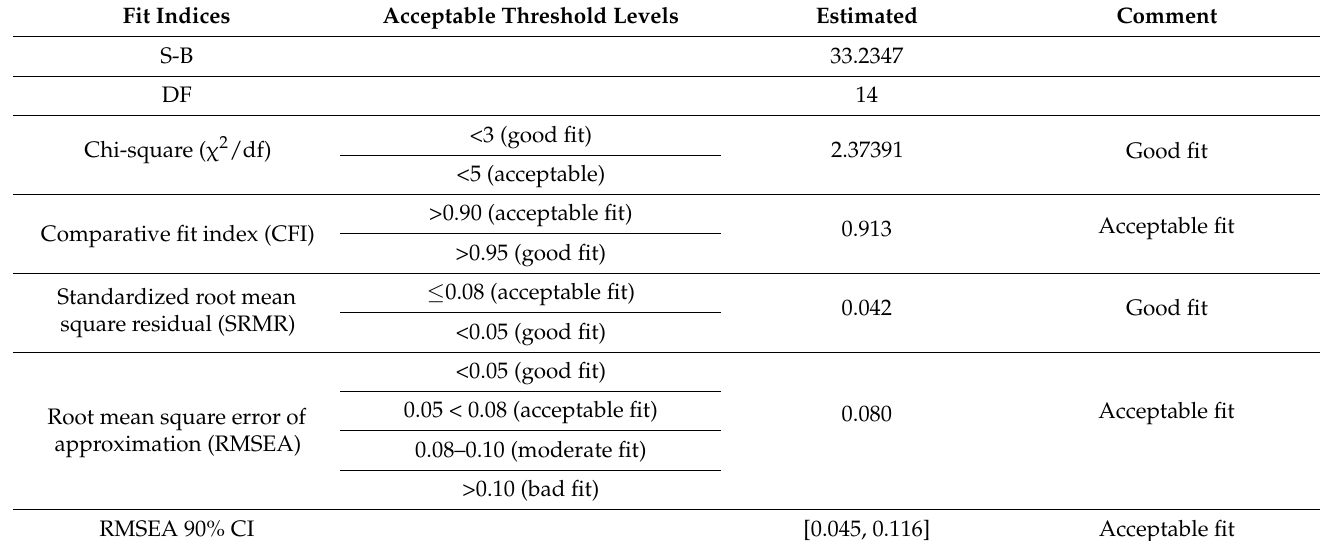
Table 10. Robust fit indexes for the Stakeholders participation (SPN)